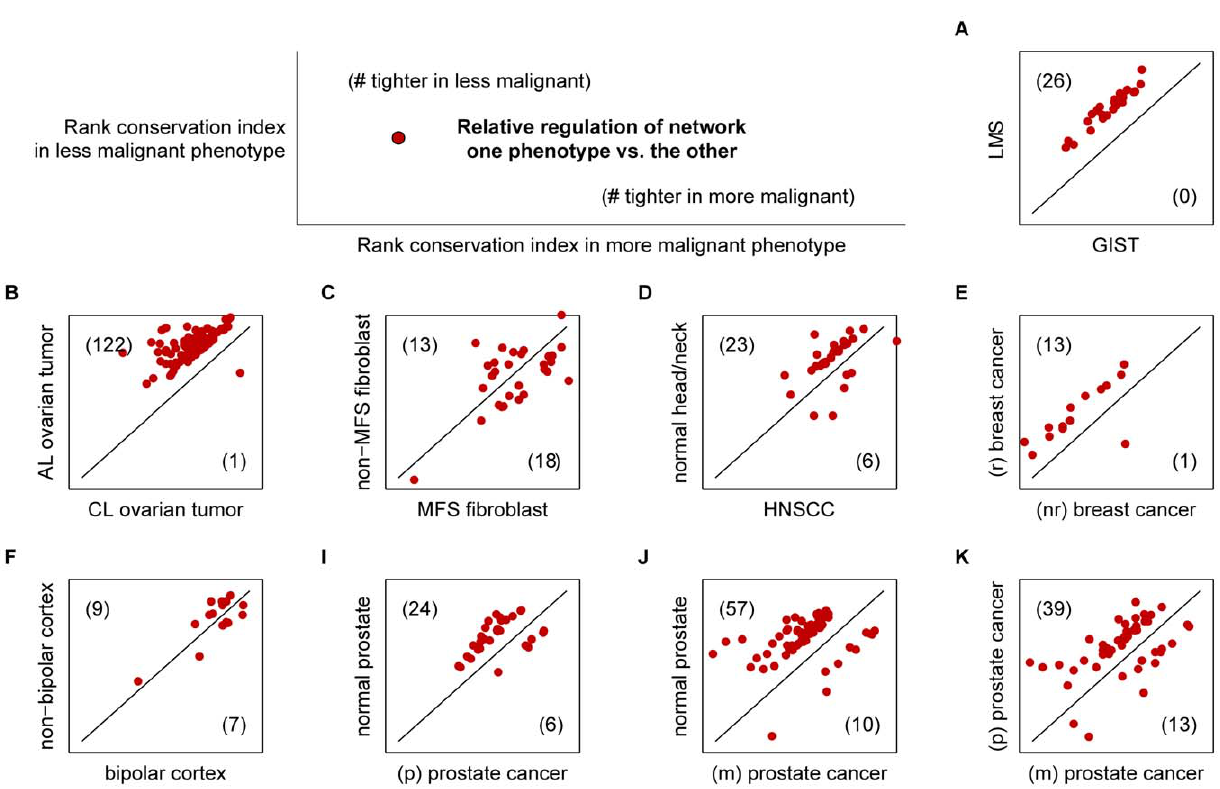
Figure 4. Deregulation of networks in disease. For each dataset, networks were selected according to the greatest absolute difference in rank conservation between the two phenotypes. Using this subset of networks, the rank conservation index values in the less malignant phenotype (y- axis) were plotted against indices in the more malignant phenotype (x-axis). Higher rank conservation in the less or more malignant phenotypes is indicated by points above or below the diagonal line, respectively. Panel labels ( A – K ) correspond to datasets listed in Table 2 .